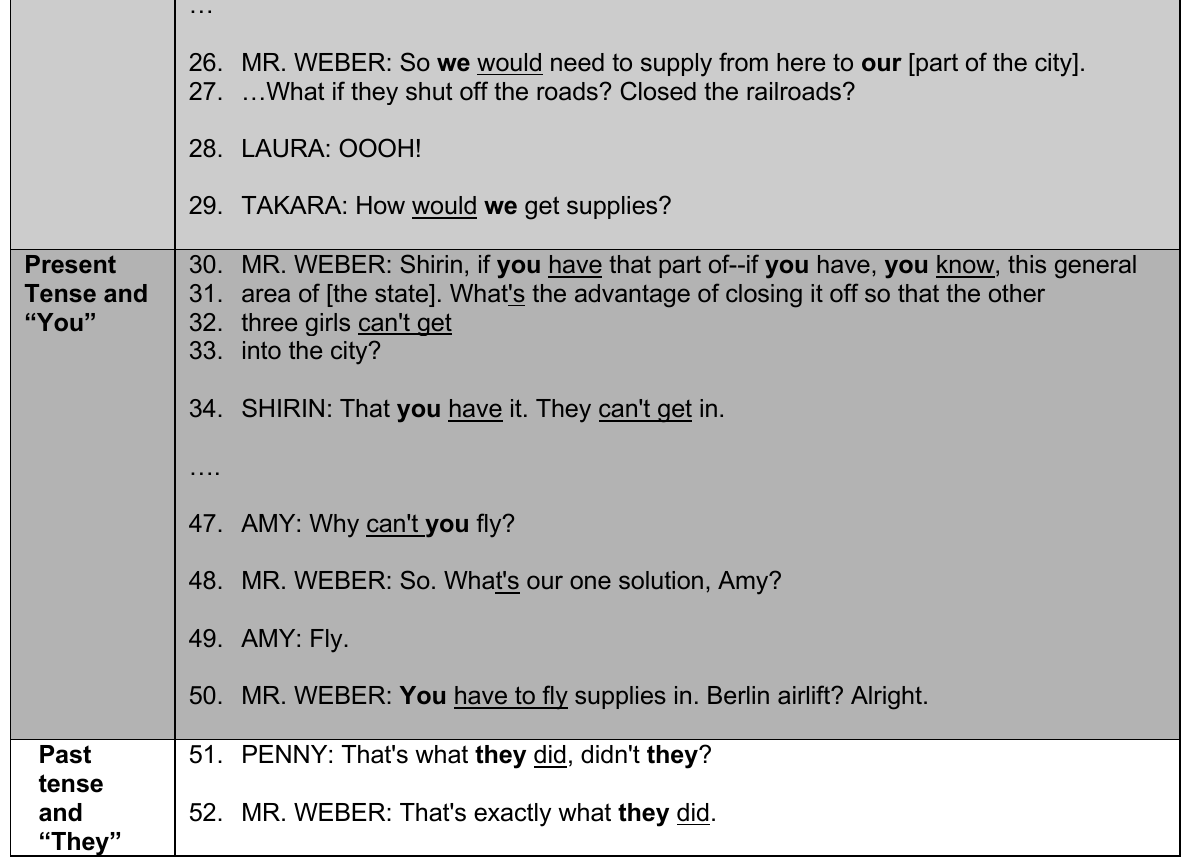
Figure 6 . Shifts in verb tense and pronoun use during dialogic, whole-class discussion of the Berlin/Capital City Airlift. (Verbs are underlined and pronouns bolded; shading indicates progression toward more present, personal uses of language).